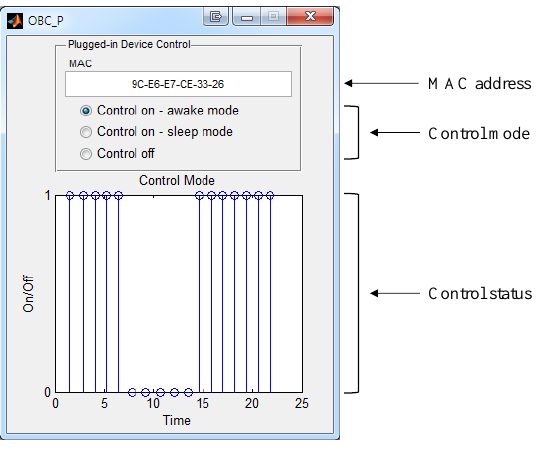
Figure 2. OBC-P software.